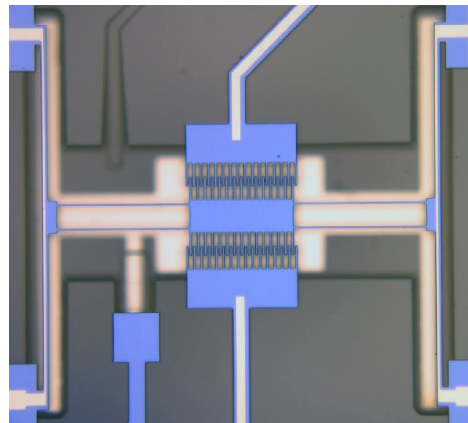
Figure 37. A resonant micromachined magnetic field sensor [315]. A DC current is passed through